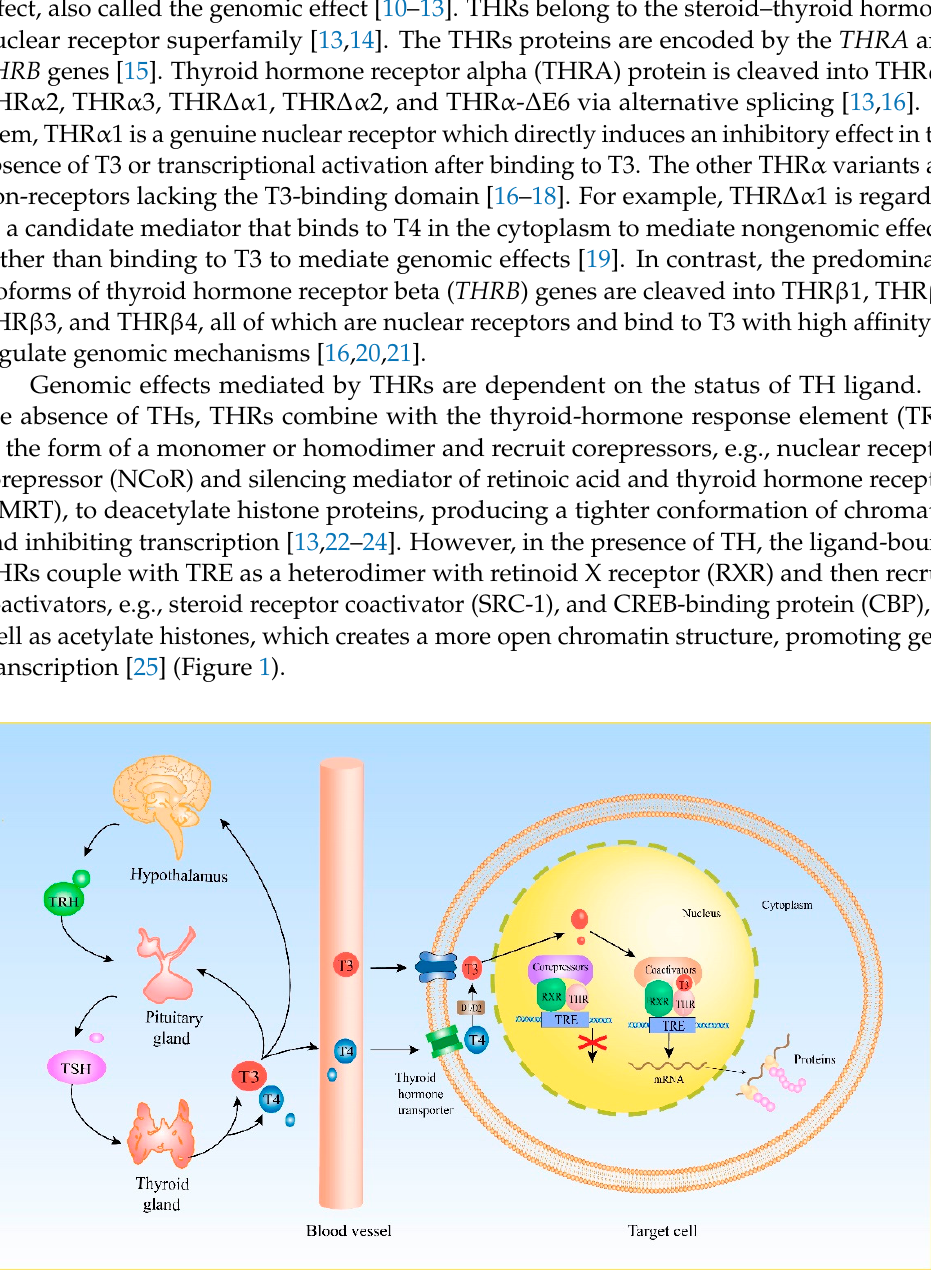
Figure 1. Secretion of TH and its genomic effect on target cells. T3 and T4 secreted by the thyroid gland are released into the blood and transported to the pituitary and hypothalamus. T3 and T4 enter the target cells through the TH transporter. After TH enters the nucleus, T4 is converted to T3 by D1/D2. Before the entry of T3 into the nucleus, THR heterodimerizes with RXR and binds to TRE on the DNA, and then recruits corepressors, inhibiting the transcription. After T3 enters the nucleus, it binds to the ligand-binding domain of THRs, disrupting the corepressor binding while promoting coactivator binding. Then it initiates transcription. Abbreviations: TRH, thyrotropin-releasing hor- mone; TSH, thyroid-stimulating hormone; T3, triiodothyronine; T4, thyroxine; D1, 1 5 ′ -deiodinase; D2, 2 5 ′ -deiodinase; RXR, retinoic acid receptor; THR, thyroid hormone receptor; TRE, thyroid-hor- mone response element. ↓ , Stimulatory function.